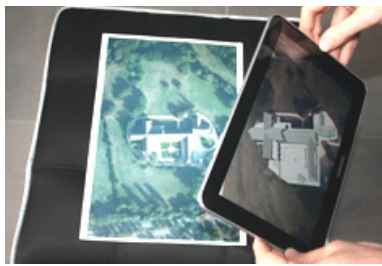
Figure 10. Play activity based on